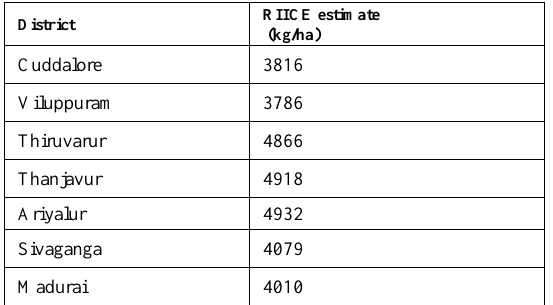
Table 4. Summary of rice yield estimates at district level.